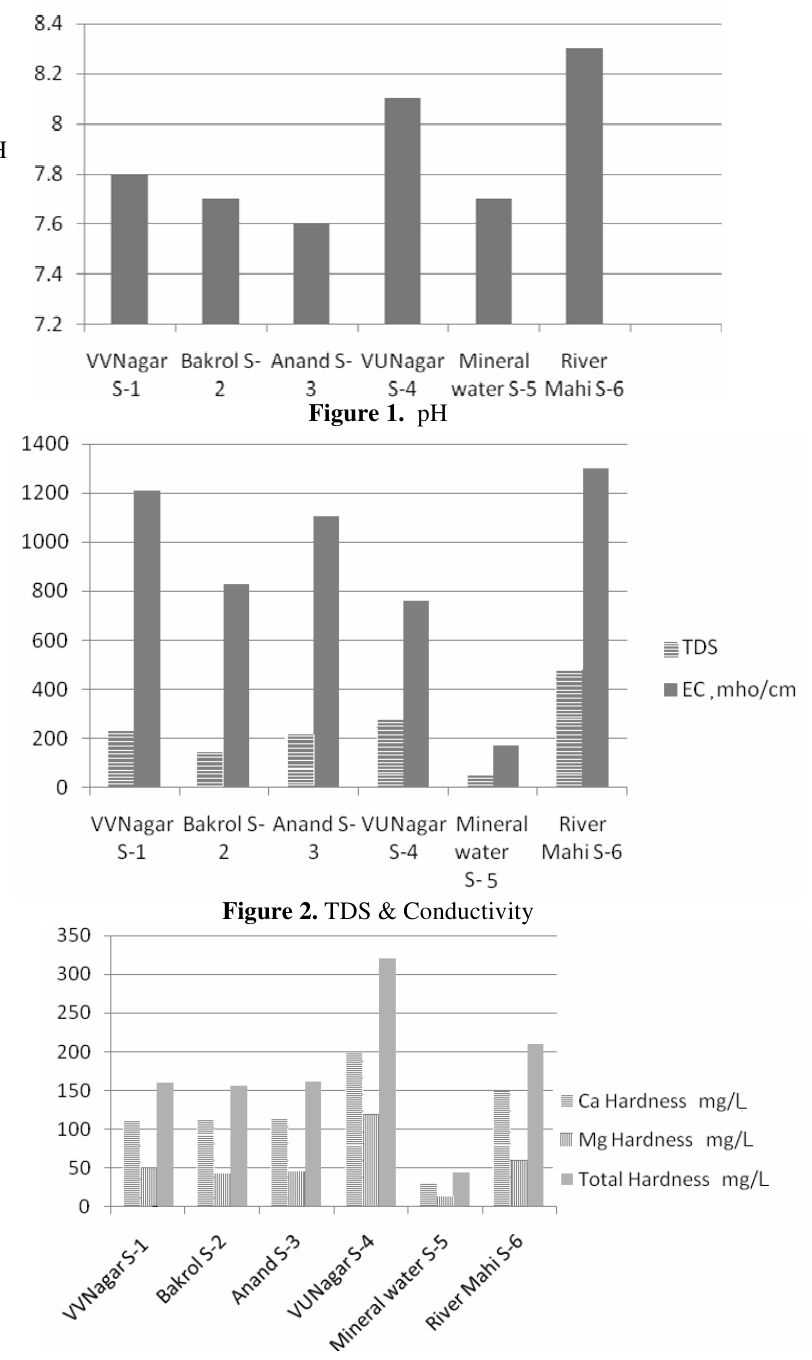
Figure 3. Calcium, Magnesium & Total Hardness